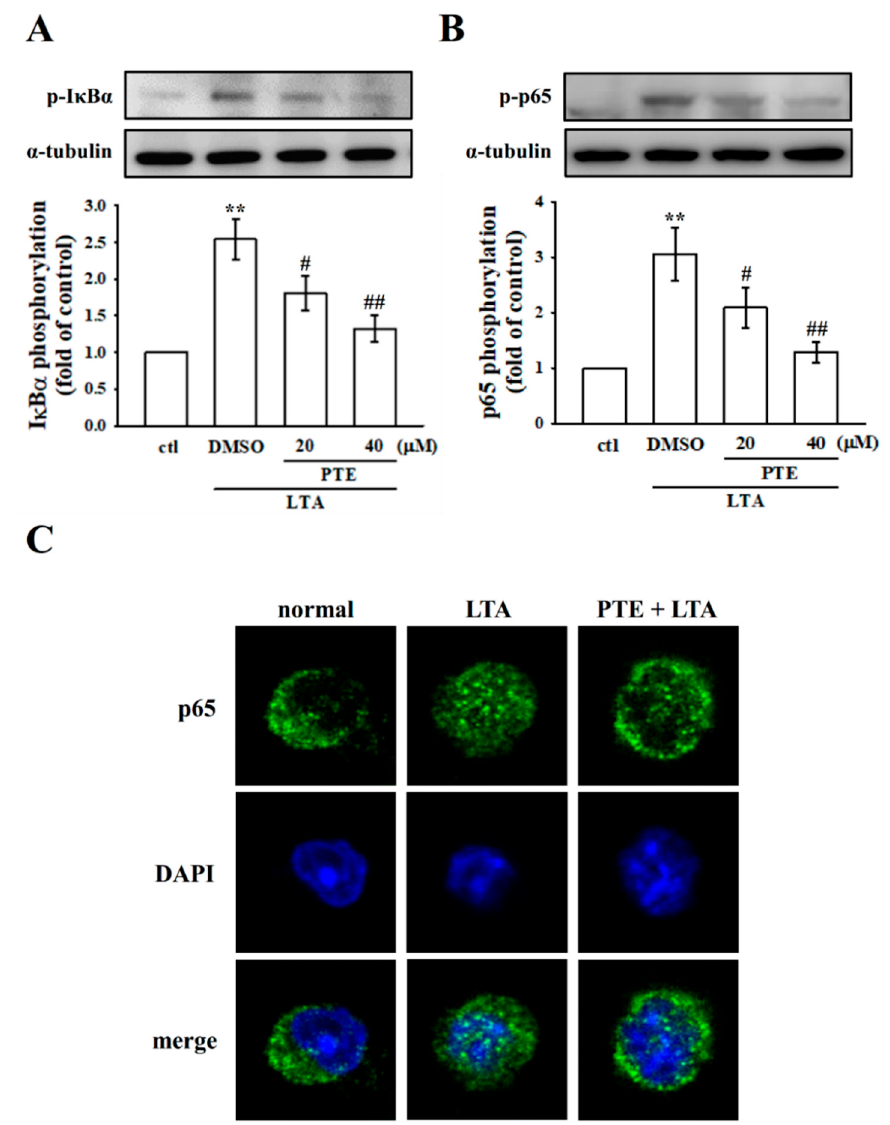
Figure 4. PTE regulates NF- κ B signaling pathway induced by LTA in RAW cells. Cells were treated with PTE (20 and 40 µ M) and LTA (5 µ g/mL) for 1 h. Western blotting assay was done to detect the phosphorylation of ( A ) I κ B α and ( B ) p65 in LTA-induced RAW cells. ( C ) PTE inhibited LTA-induced p65 nuclear translocation. ** p < 0.01 vs. control cells; # p < 0.05, and ## p < 0.01 vs. PTE pretreated cells ( n = 4).